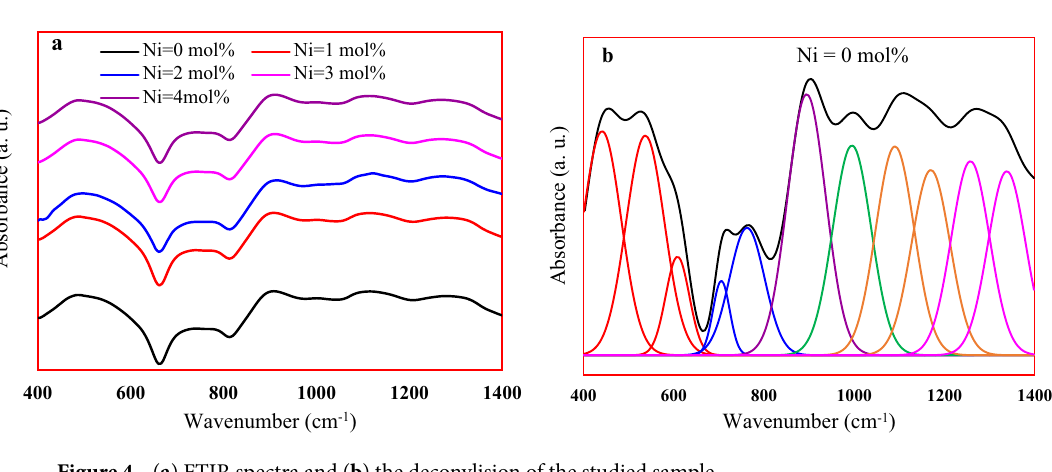
Figure 4. ( a ) FTIR spectra and ( b ) the deconvlision of the studied